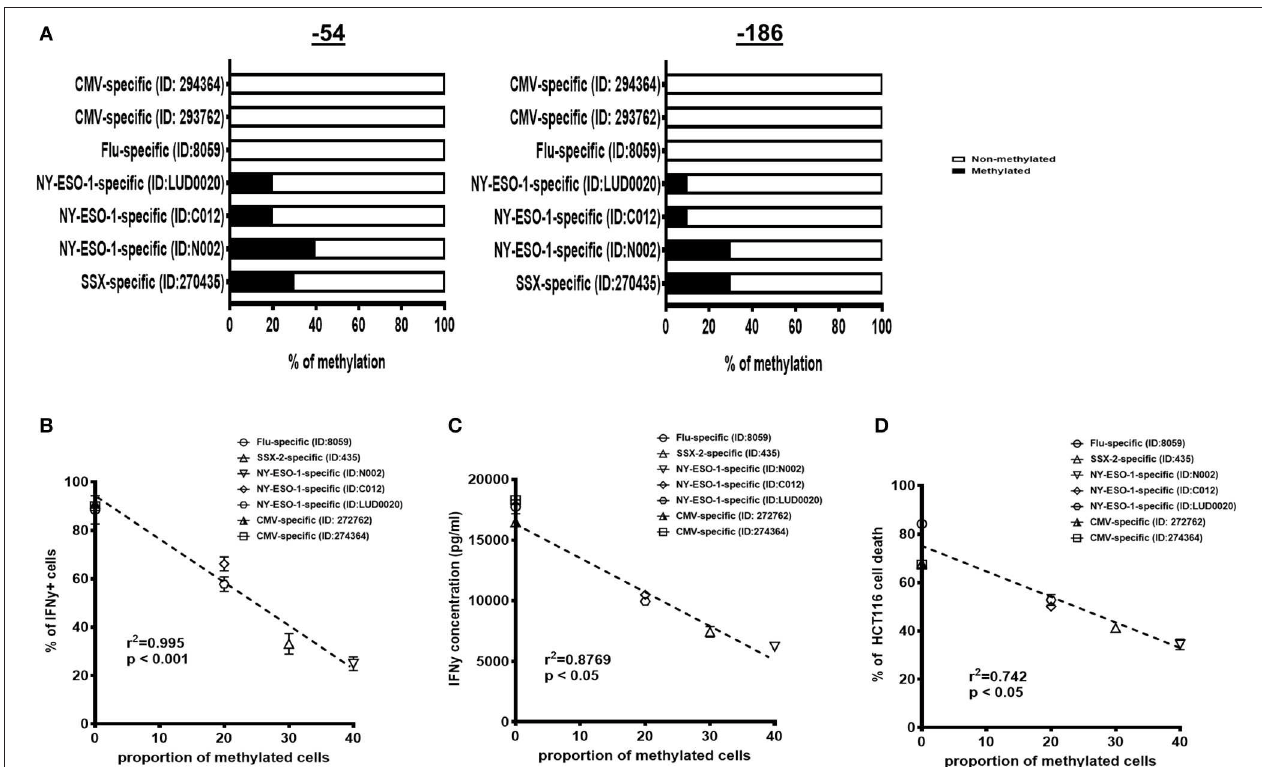
FIGURE 3 | Interferon gamma (IFN γ ) methylation and correlation to IFN γ production and T cell cytotoxicity of short-term expanded bulk antigen-specific cytotoxic T lymphocytes (CTLs). (A) Proportion of cells with methylation at positions − 186 and − 54 for each group of antigen-specific T cells [influenza-specific T cells, cytomegalovirus (CMV)-specific T cells, synovial sarcoma X (SSX)-2-specific T cells, and New York-esophageal squamous cell carcinoma-1 (NY-ESO-1)-specific T cells derived from different patients]. The proportion of cells with a hypermethylated IFN γ promoter inversely correlates with the proportion of IFN γ mRNA + cells (B) and IFN γ protein production (C) expressed for each antigen-specific T cell type. (D) The proportion of cells with a hypermethylated IFN γ promoter inversely correlates with HCT116 cancer cell death induced by antigen-specific T cells at 1 µ g/ml of antigen stimulation. N , number of experimental repeats = 3. Analysis performed with non-parametric Spearman correlation